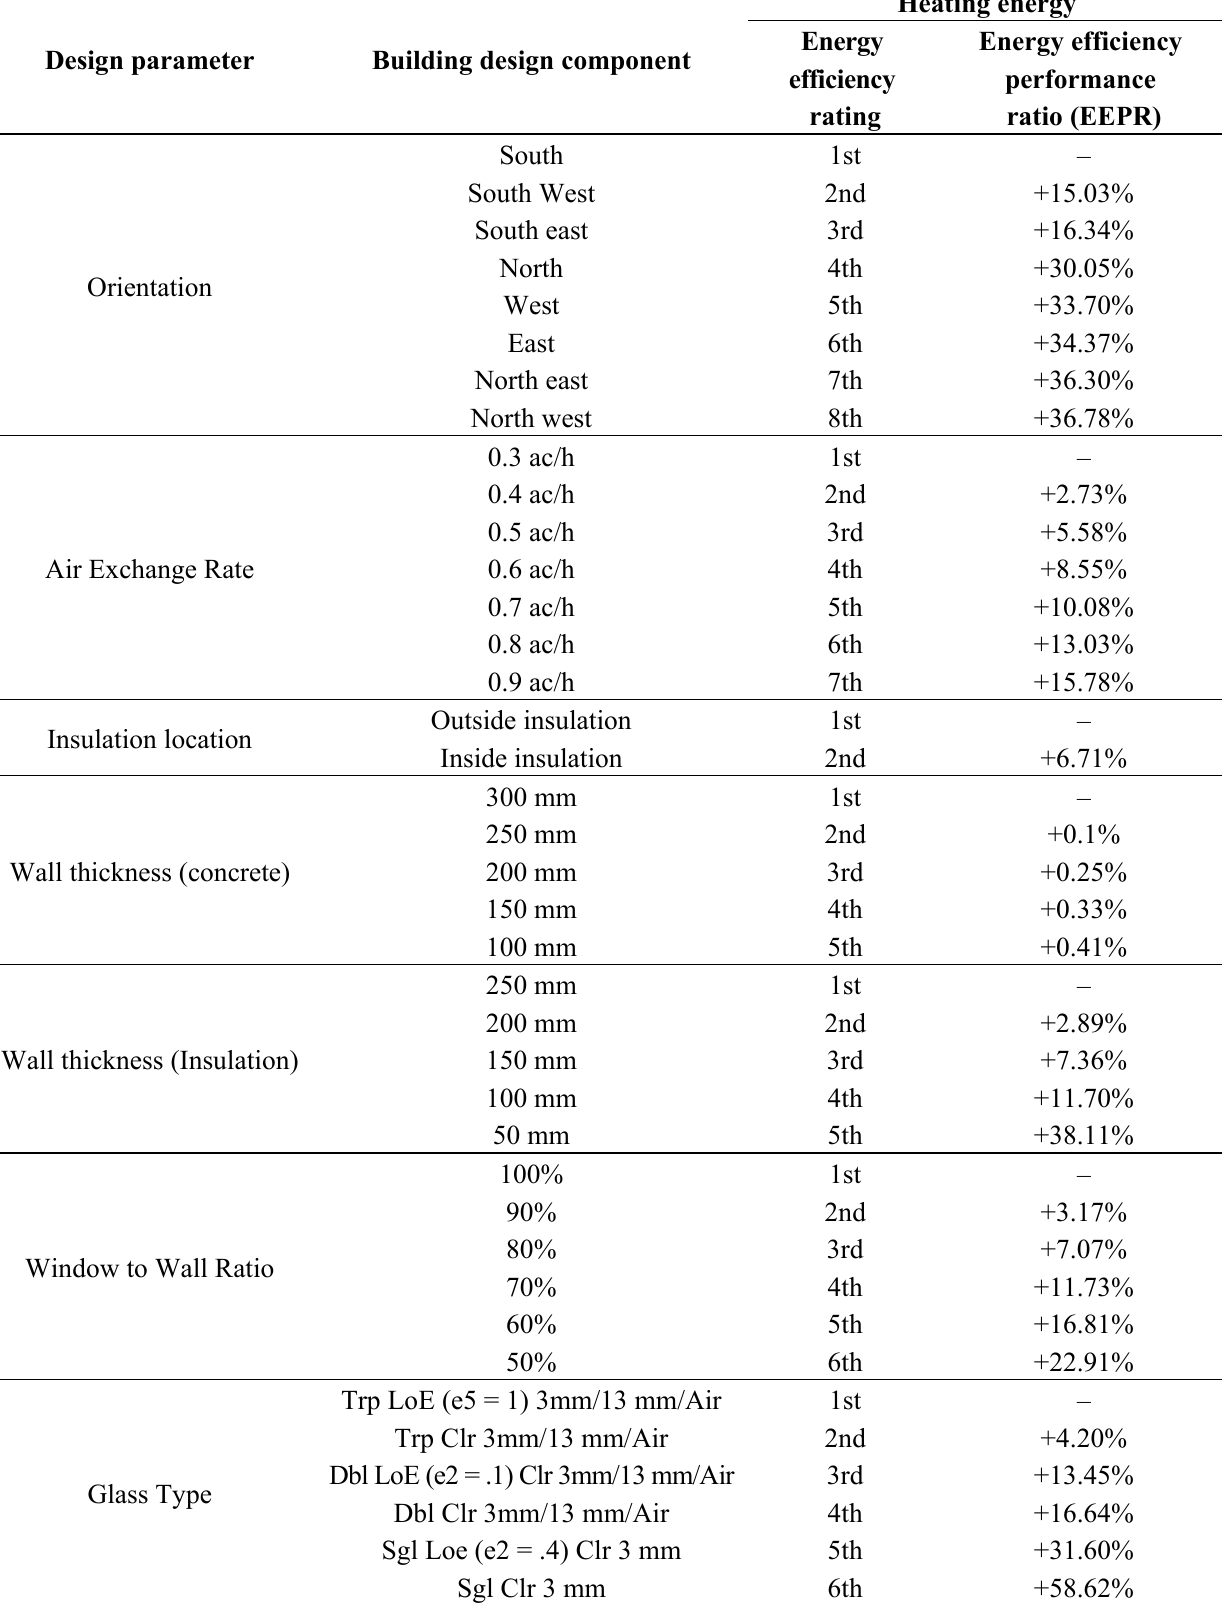
Table 9. Energy efficiency rating calculation table for heating energy